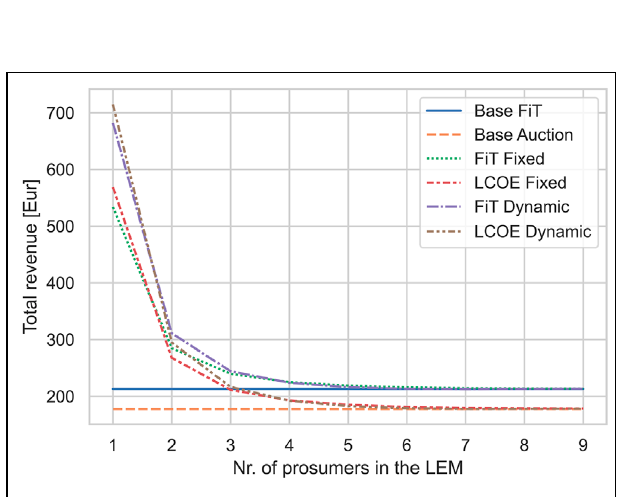
FIGURE 12 | Annual revenue for Prosumer 1, depending on the number of prosumers in the